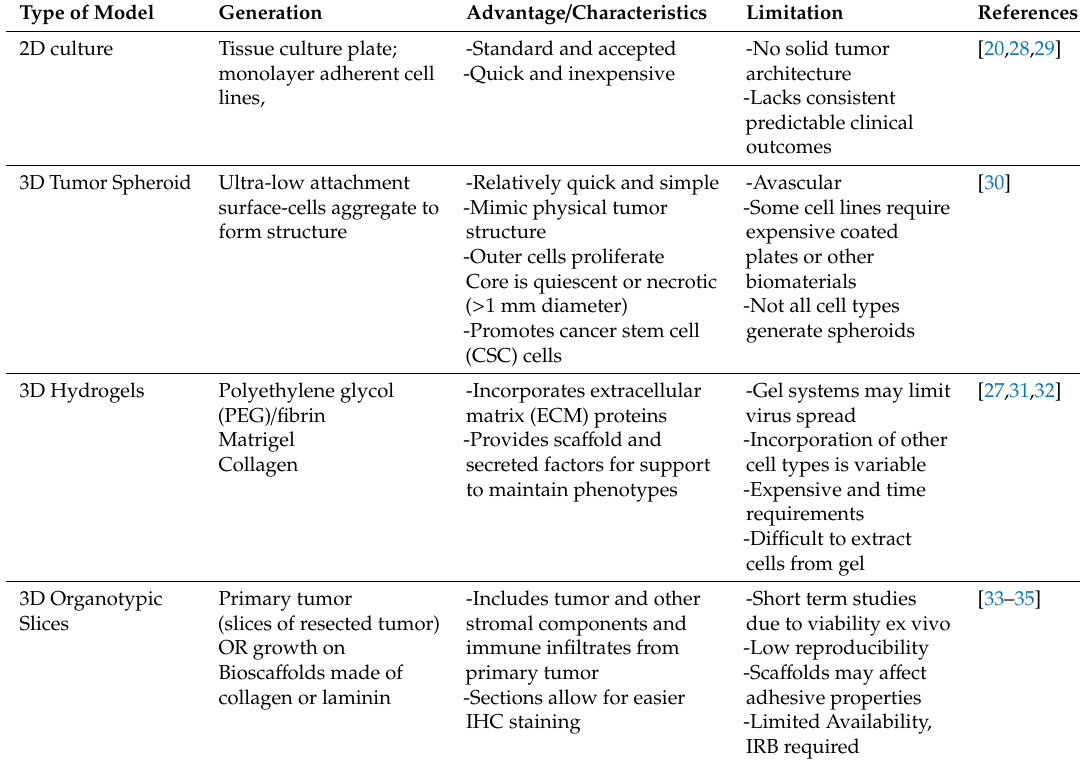
Table 1. Summary of current tissue culture